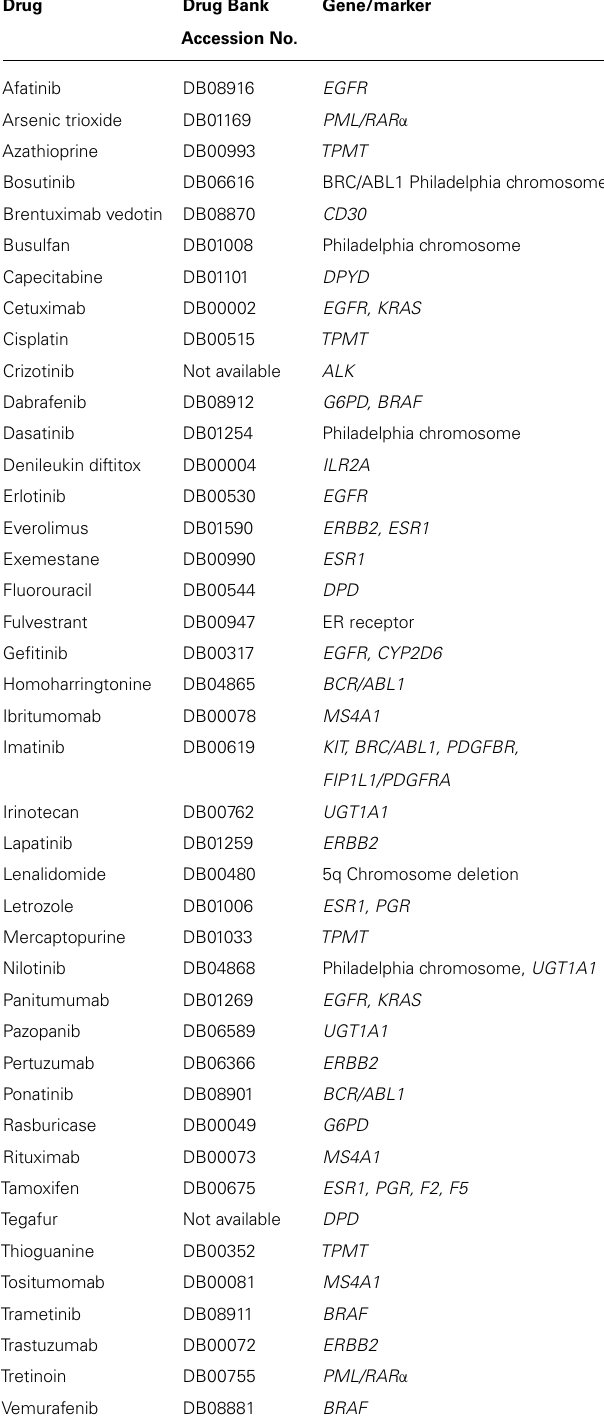
Table 1 | Examples of anticancer drugs with pharmacogenomic